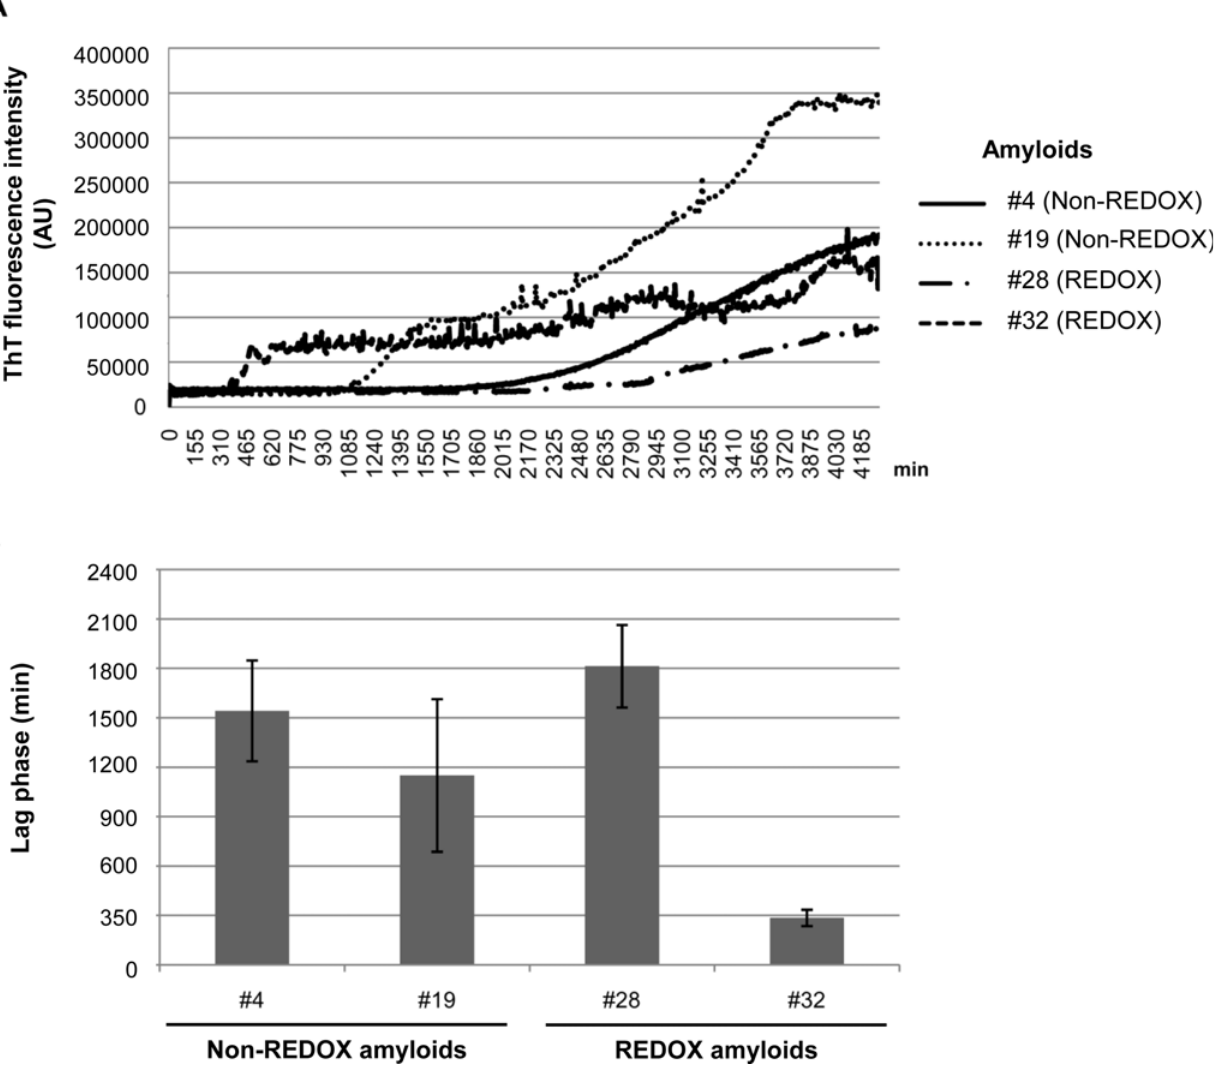
Fig 1. Aggregation assay of recMoPrP(23 – 231). Recombinant mouse PrP residues 23 – 231 (recMoPrP(23 – 231)) was converted in vitro into different amyloid forms (amyloids #4, #19, #28, #32). The amyloid preparations shown ( A ) exhibited different kinetics for the formation of recMoPrP(23 – 231) aggregates. Lag phase distribution of amyloid preparations. Bars indicate standard deviation ( B